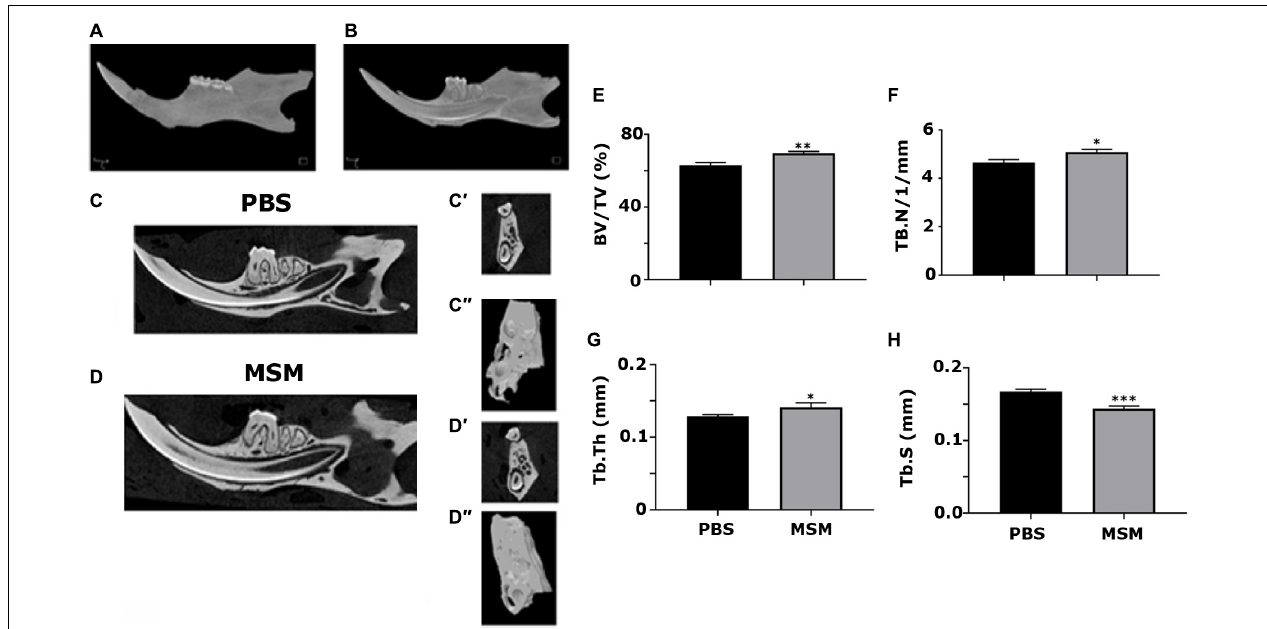
FIGURE 3 | Microcomputed tomography analysis of mandibular bone in mice injected with PBS and MSM. (A,B) A 3D construction of the (A) whole mandible and a sagittal section displaying the (B) teeth inside their respective sockets are shown. Representative sagittal (C,D) and coronal (C (cid:48) ,D (cid:48) ) planes of mandibles isolated from mice injected with (C) PBS and (D) MSM are shown. For the micro-CT scanning of the panels (C (cid:48) ,D (cid:48) ,C (cid:48)(cid:48) , and D (cid:48)(cid:48) ) , the ROI outlined (blue) in the (B) sagittal and (C) coronal planes are shown in Figure 1 were used. The micro-CT parameters were compared in six mice per group, and statistical analyses were performed using the Mann–Whitney U test for the indicated morphometric parameters (E–H) . The data are shown as mean ± SEM; ∗ p < 0.05, ∗∗ p < 0.01, ∗∗∗ p < 0.001, vs. PBS-injected mice (BV/TV, bone volume-to-tissue volume; Tb. N, trabecular number; Tb, Th, trabecular thickness; Tb. S, trabecular spacing, or